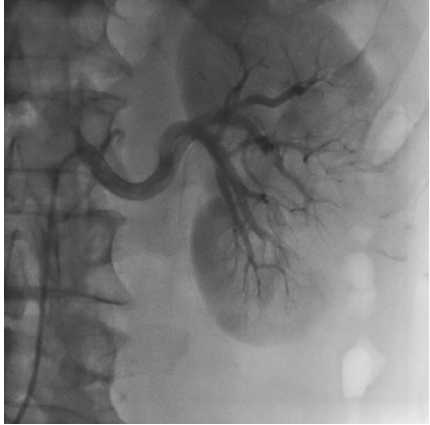
Figure1:Firstrenalarteryangiographyshowingthemultiplethrom- boembolic materials in the left renal artery branches.